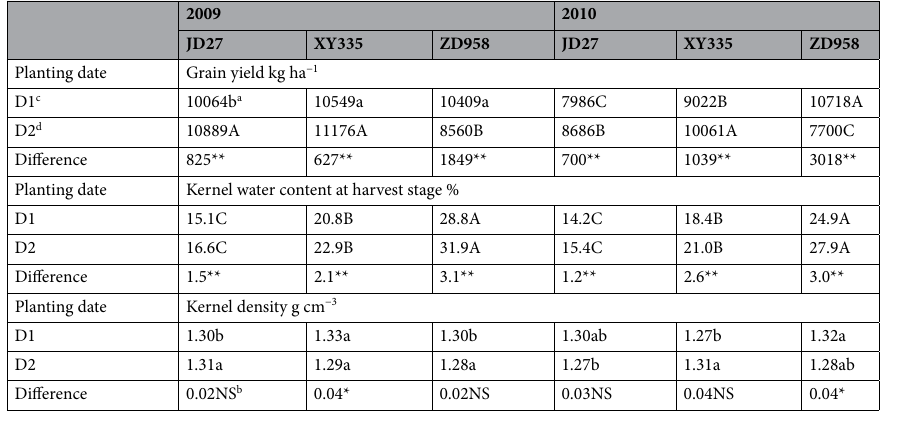
Table 3. Effects of planting date and hybrid maturity on grain yield, kernel water content at harvest stage and kernel density of dryland corn at Lishu city, Northeast China during 2009 and 2010 growing seasons. a Means within a row followed by a different lower-case letter differ at P < 0.05. Means within a row followed by a different upper-case letter differ at P < 0.01. b NS, not significant. c D1 represents the planting date of maize in early May. The planting dates for 2009 and 2010 were May 2 and May 4, respectively. d D2 represents the planting date of maize in mid-May. The planting dates for 2009 and 2010 were May 12 and May 14, respectively. * Significant at the 0.05 level. ** Significant at the 0.01